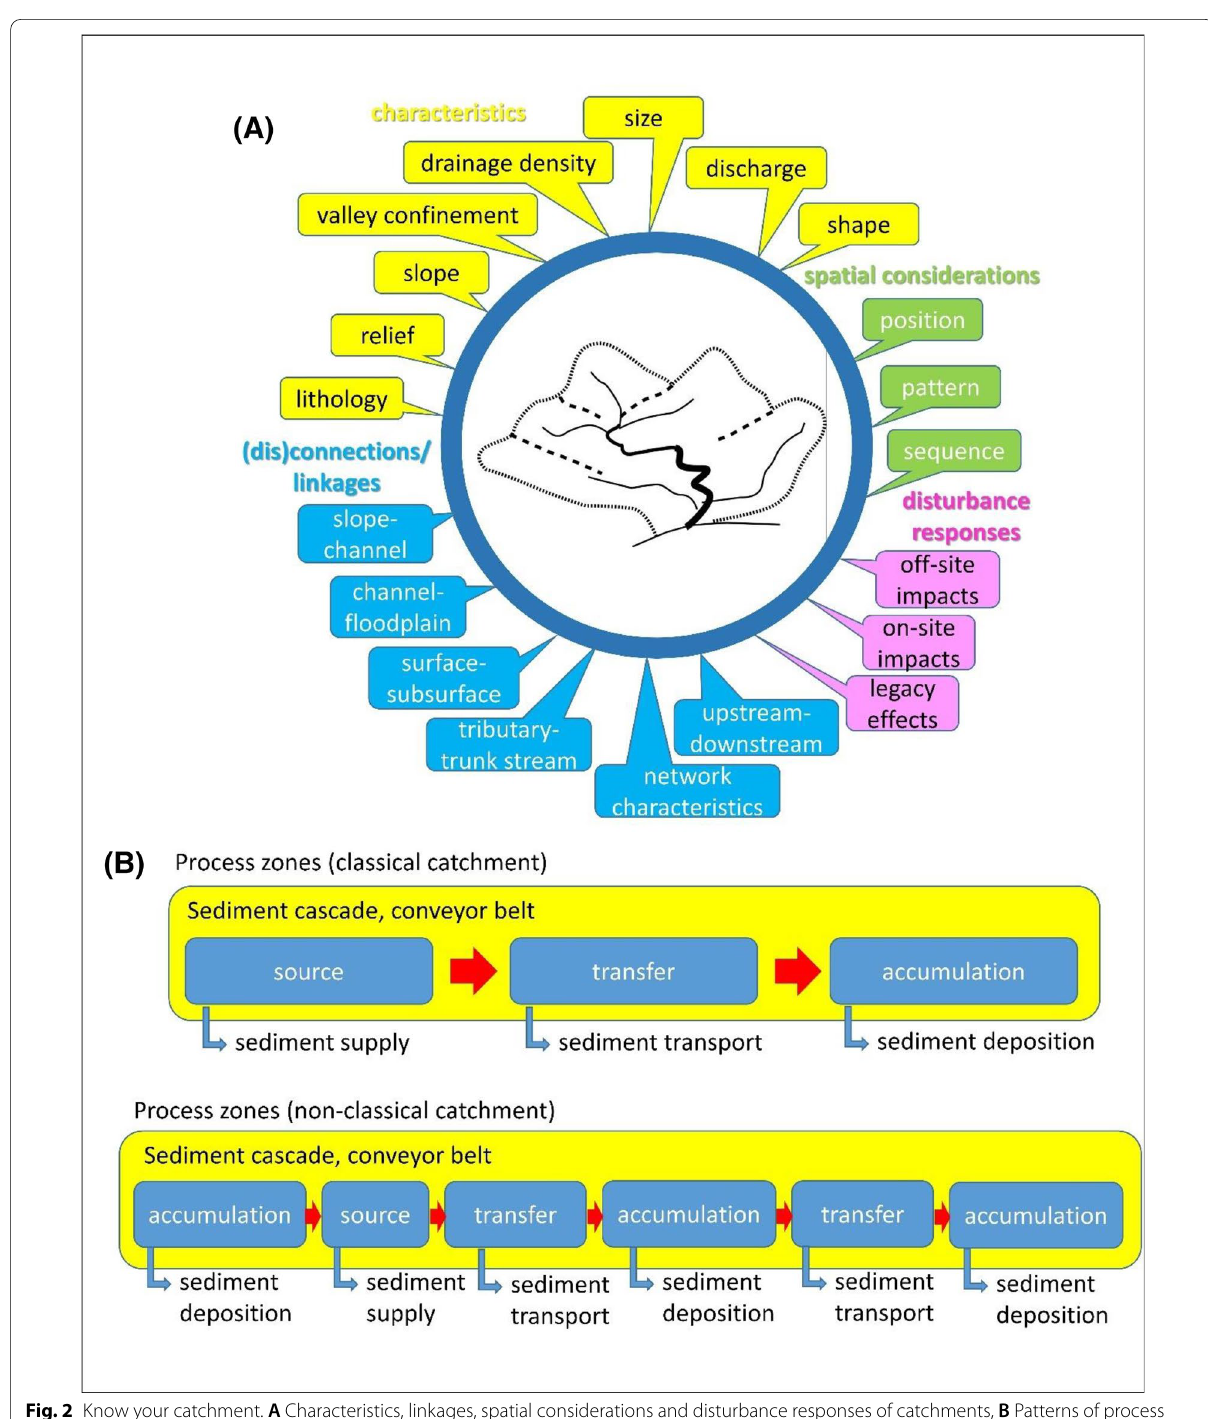
Fig. 2 Know your catchment. A Characteristics, linkages, spatial considerations and disturbance responses of catchments, B Patterns of process zones at the catchment scale, C Longitudinal profiles provide a tool to interpret and communicate controls on catchment-scale sequences and patterns of river types. This example is from the Middle Fork John Day, USA and has been modified from O’Brien et al. (2017) and Fryirs et al.